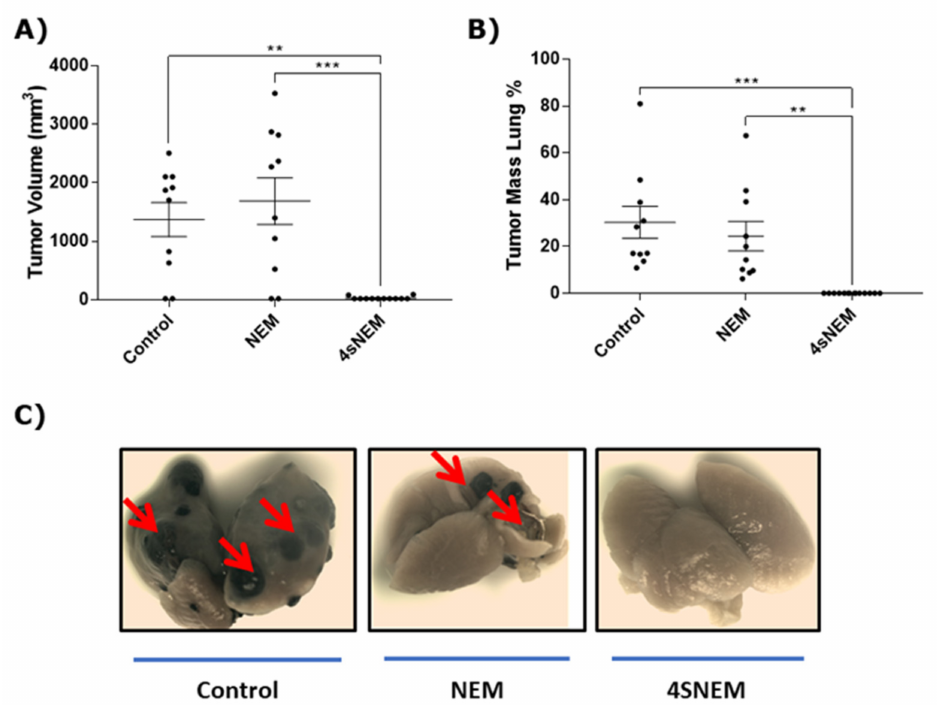
Figure 8. Efficacy of the 4s compound delivered in an oil-in-water (O/W) nanoemulsion ( 4s -NEM) in a preclinical mouse model. Recurrent tumour growth at the initial site ( A ) and lung metastases ( B ) were evaluated 21 d post-surgery. Mice were injected with B16F10 cells subcutaneously in their flanks. The resulting tumours were surgically removed, and the wounded zone was either not treated (control) or treated with NEM or with 4s -NEM. Mice were sacrificed 21 d later to evaluate the efficacy of the treatments. Results are presented as the mean ± SD of n = 10–12 mice. (***) p < 0.001, (**) p < 0.01 vs. control. Data analysis was performed via a non-parametric Mann–Whitney test. ( C ) Representative images of lung metastases in control mice (control and NEM) and of animals treated with 4s -NEM. Note the complete absence of lung metastases in animals treated with 4s -NEM compared to controls (red